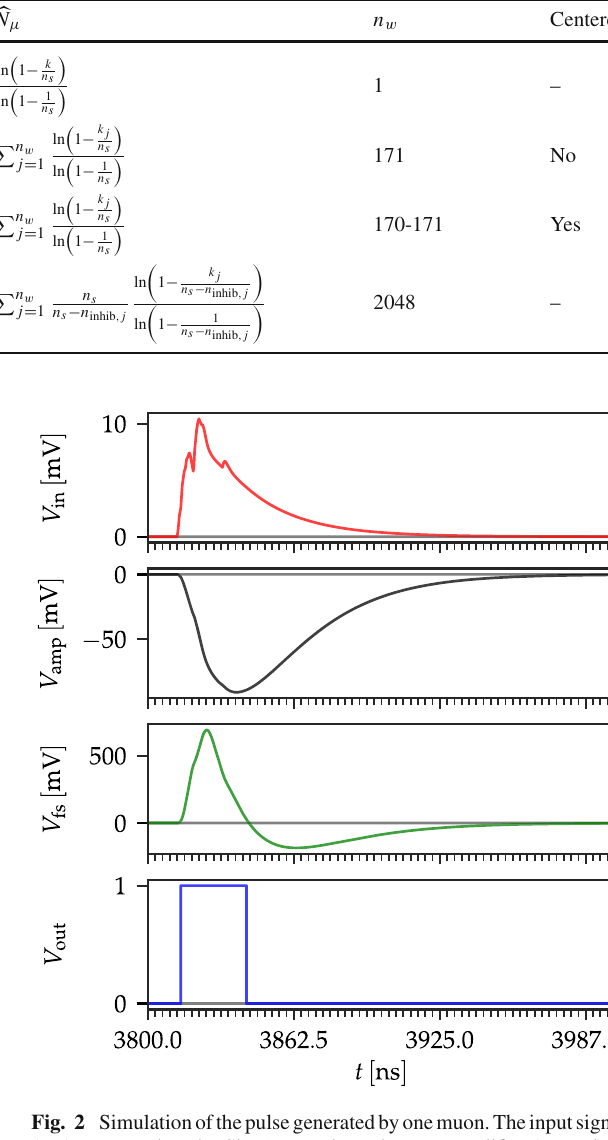
“Centered” details whether the position of the windows is chosen such that one of those is centered in the peak of the signal